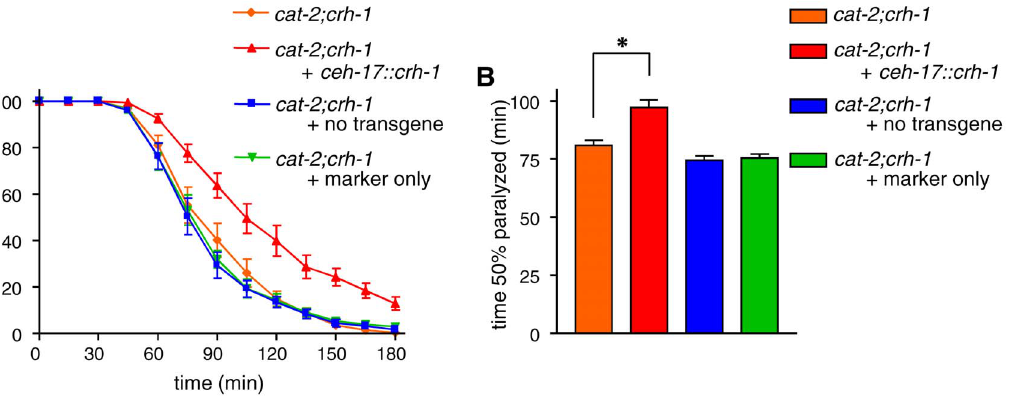
Figure 4. crh-1 expression in SIA neurons rescued aldicarb resistance in the cat-2;crh-1 double mutant. cat-2;crh-1 mutants were transformed with ceh-17::crh-1 and the co-injection marker lin-44::gfp . (A) Animals were examined for paralysis on NGM plates containing 1 mM aldicarb. (B) The time required for 50% of the animals to become paralyzed was determined using Prism. Animals carrying the transgene exhibited stronger aldicarb resistance than did the original double mutants. Those animals that lost the transgene or that were transformed only with the co- injection marker showed similar levels of aldicarb sensitivity to the cat-2;crh-1 double mutants. *P , 0.001 by the Tukey-Kramer multiple comparison test. Error bars indicate the SEM.